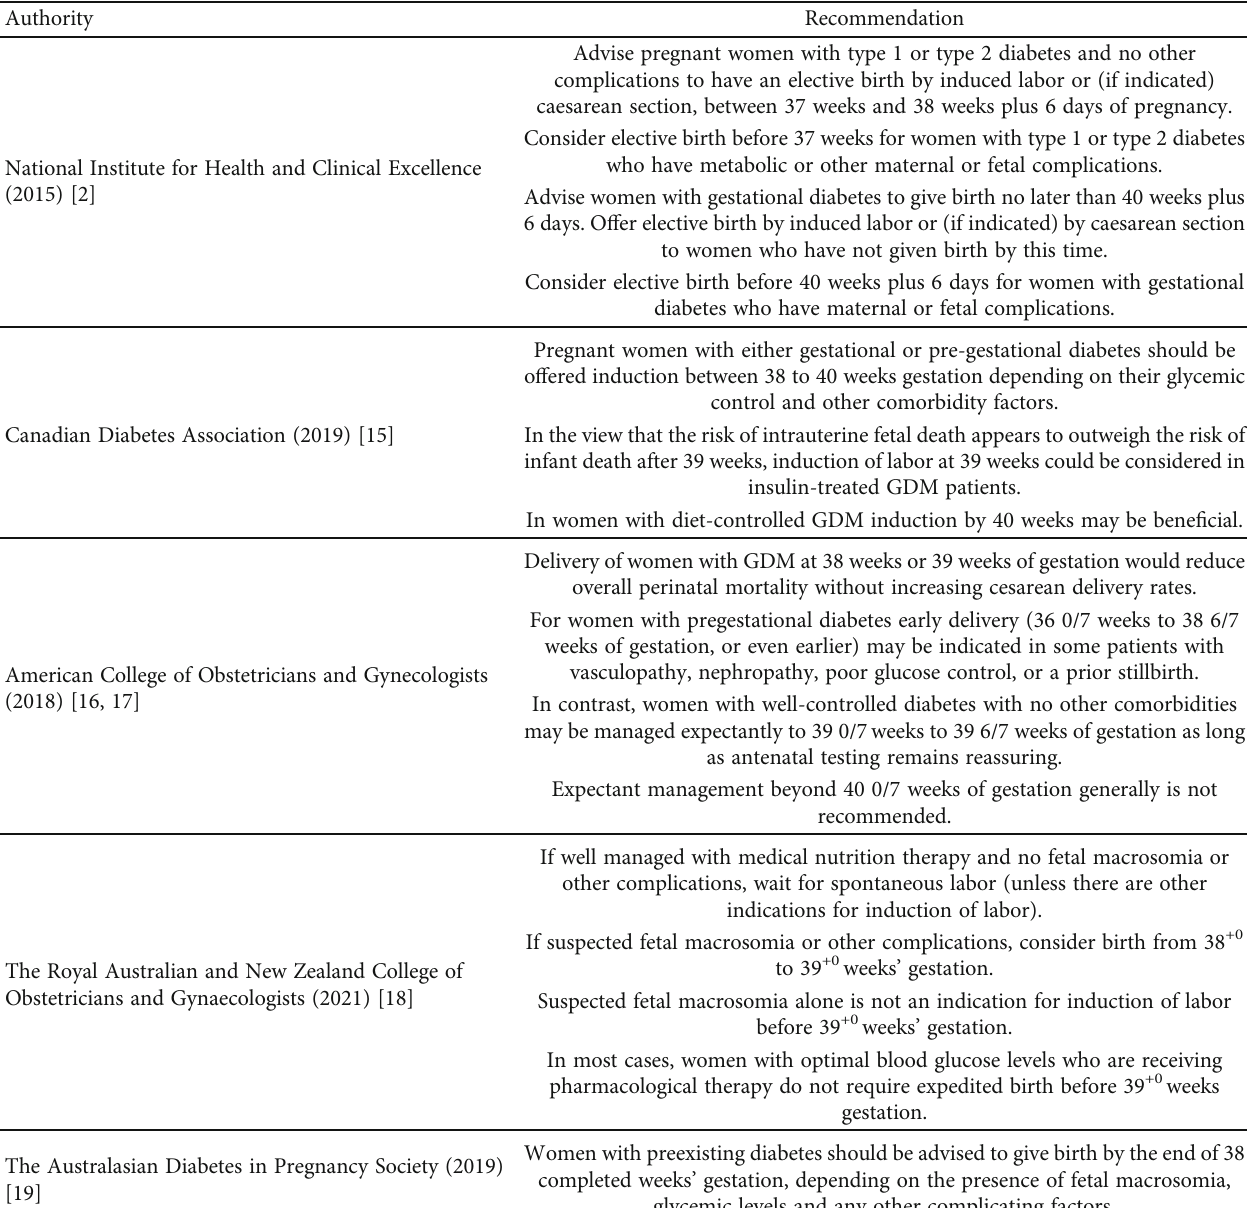
Table 5: Comparison of di ff erent international guidelines regarding the optimal time of delivery in women with diabetes in pregnancy. GDM: gestational diabetes